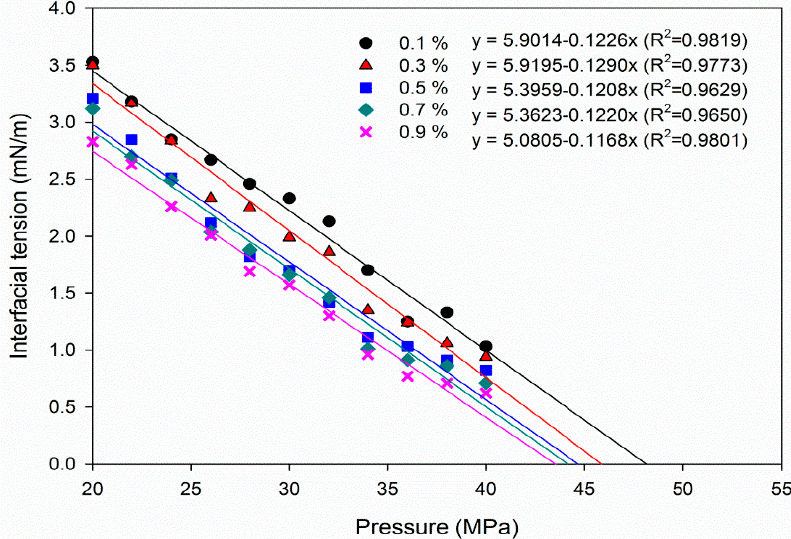
Figure 11. Changes of CO 2 –oil IFTs with pressures for the crude oil diluted with different mass concentrations of petroleum ether in the boiling range of 30 ‒ 60 °C.